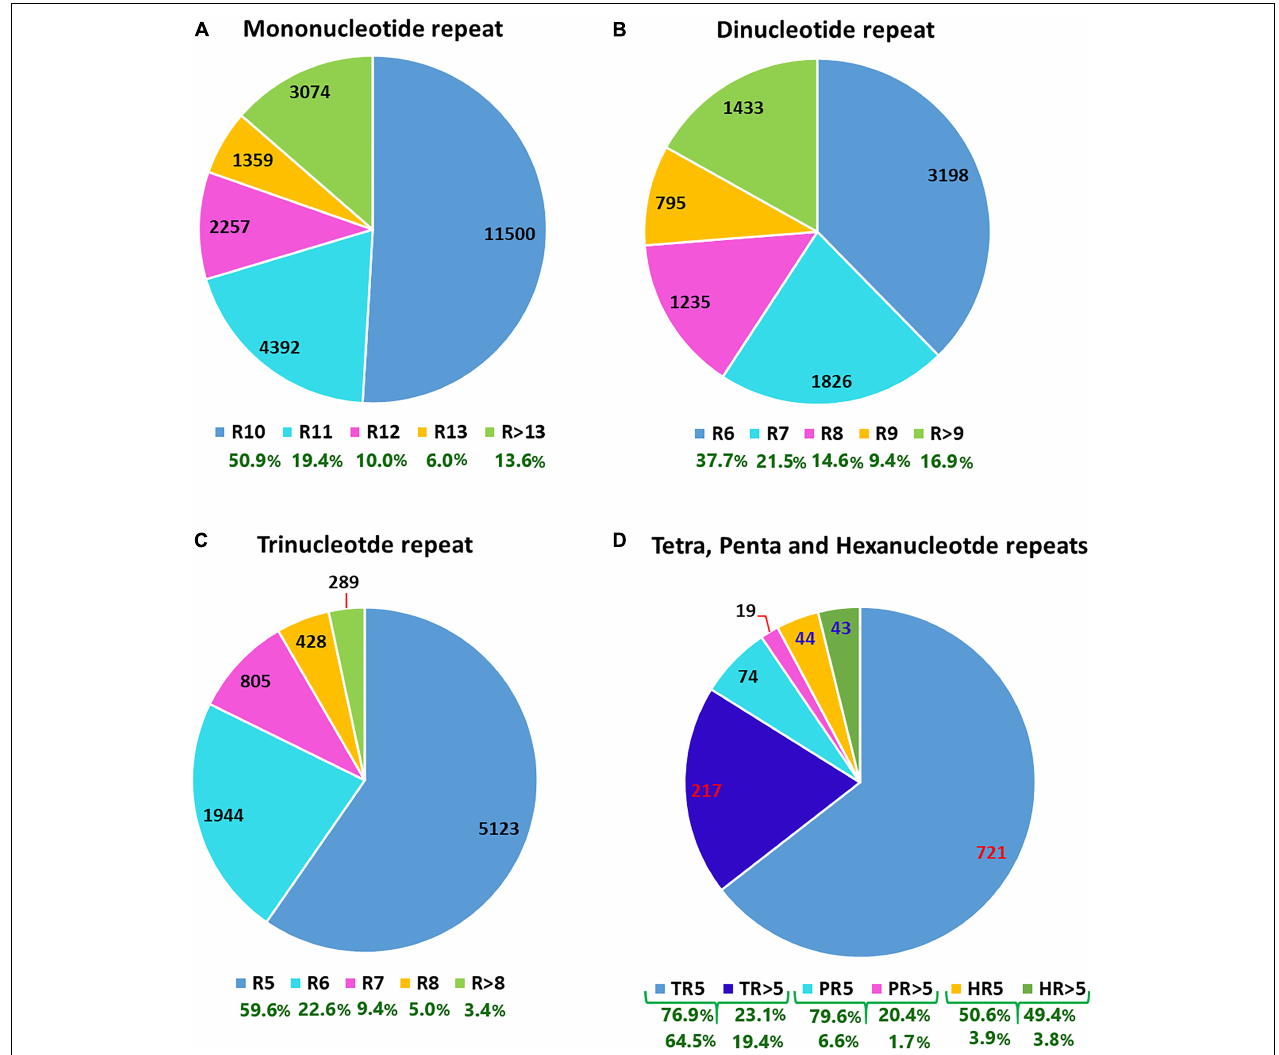
FIGURE 1 | P-charts depicting the number (values in the pie charts) and percentage (values shown below the chart keys in green) of different simple sequence repeat motifs across the noug unigenes that were classified based on the number of times they were repeated. In the chart keys of panels (A–C) , the numbers following “R” denote the number of times the corresponding repeat motifs were repeated. In the chart keys of (D) , T, P and H refer to Tetra, Penta and Hexanucleotide repeats. “ > ” indicates that the SSR motif was repeated more times than the specified number.